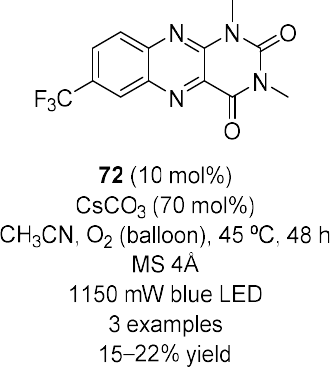
Figure 20. Results obtained in the aerobic photo-oxidation of aliphatic alcohols to ketones 69 cata- lyzed by 72